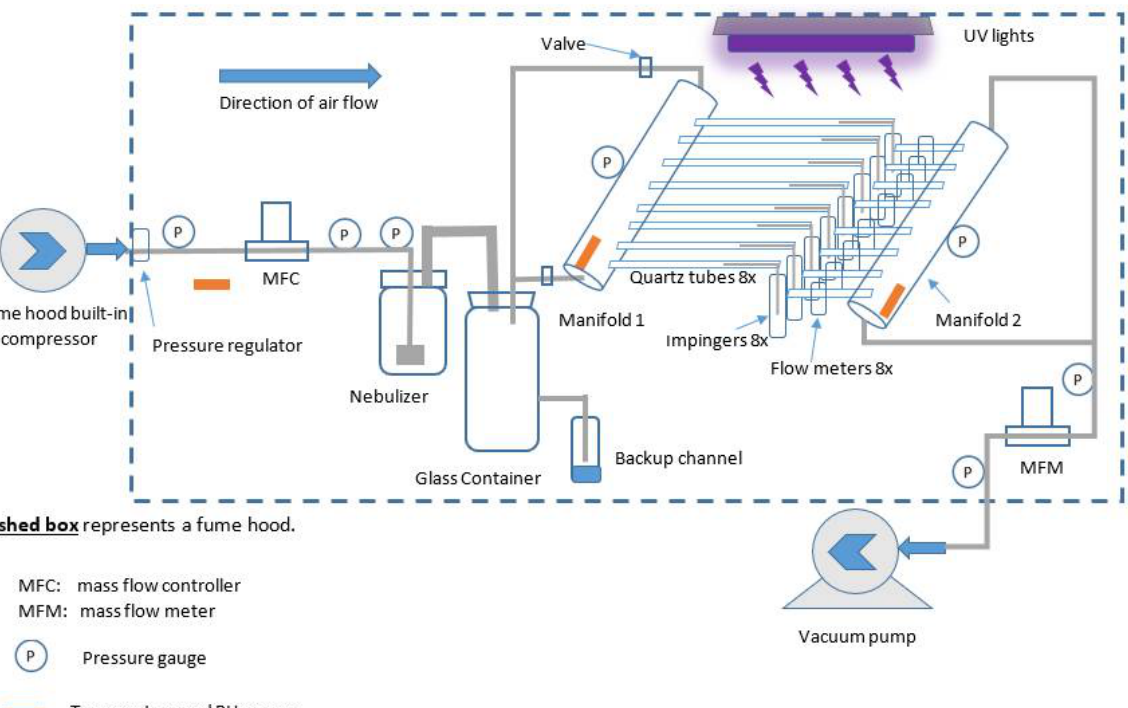
Figure 1. Experimental setup for porcine reproductive and respiratory syndrome virus (PRRSV) aerosol generation, UV treatment, and collection of treated PRRSV aerosols inside a fume hood.